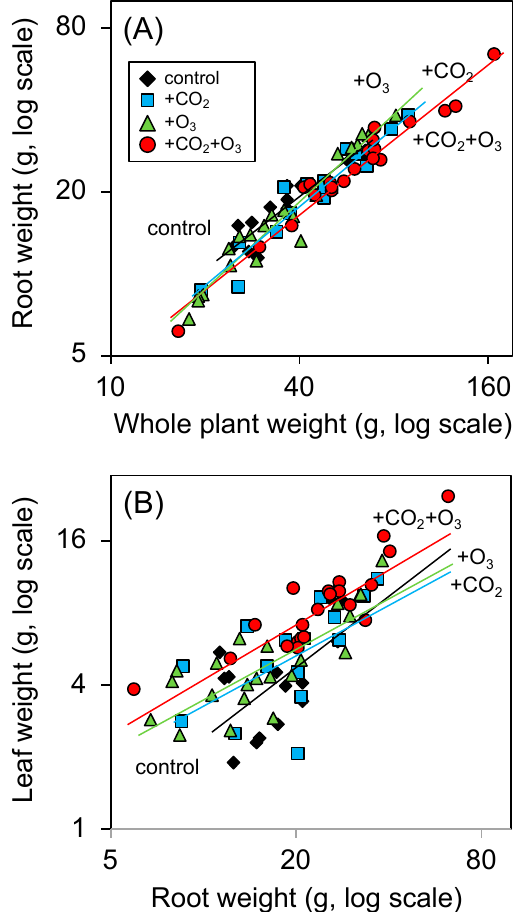
Figure 3. Allometric relationships between whole plant weight and root weight ( A ) and between root weight and leaf weight ( B ) of F. crenata seedlings. Allometric equations analyzed by using an R package, smart 3 (SMA analysis), are listed in Table 4. Diamond (black): control, square (blue): elevated CO 2 , triangle (green): elevated O 3 , circle (red): the combination of elevated CO 2 and O 3 . Each colored line shows regression line for each treatment. Table 4. Standardized major axis (SMA) regression slopes and their confidence intervals for log-log transformed relationships between whole plant weight and root weight (Figure 3A) and between root weight and leaf weight (Figure 3B) of F. crenata seedlings grown under ambient air (control), elevated CO 2 (+CO 2 ), elevated O 3 (+O 3 ), and the combination of elevated CO 2 and O 3 (+CO 2 +O 3 ). Values of coefficients of determination ( r 2 ) and significant values ( p ) of each bivariate relationship are shown. 95% confidence intervals (CI) of SMA slopes and y -axis intercepts are exhibited. In cases where SMA tests for common slopes revealed no significant differences between treatments, common slopes are used. The differences in elevations of the SMA regressions are tested among treatments using Sidak’s adjusted pair-wise test, depending on the significance of the null hypothesis